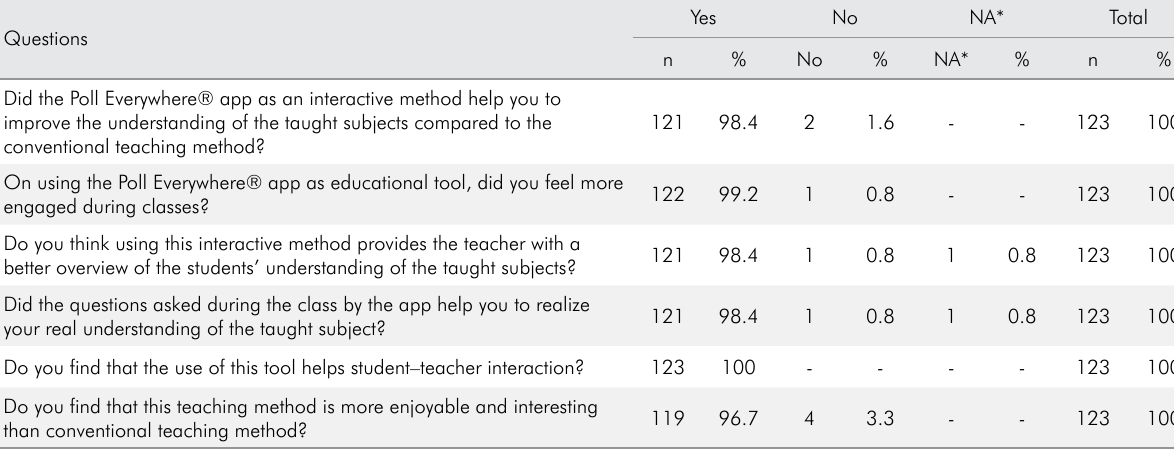
Table. Students’ perceptions of web-based interactive teaching method.